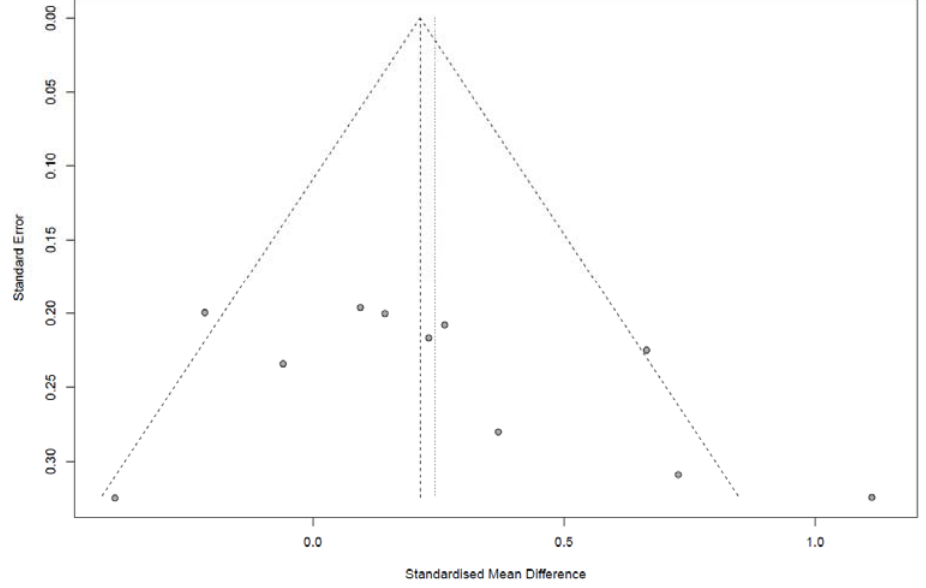
Figure 10. Funnel plot of studies that measured IBS related quality of life .